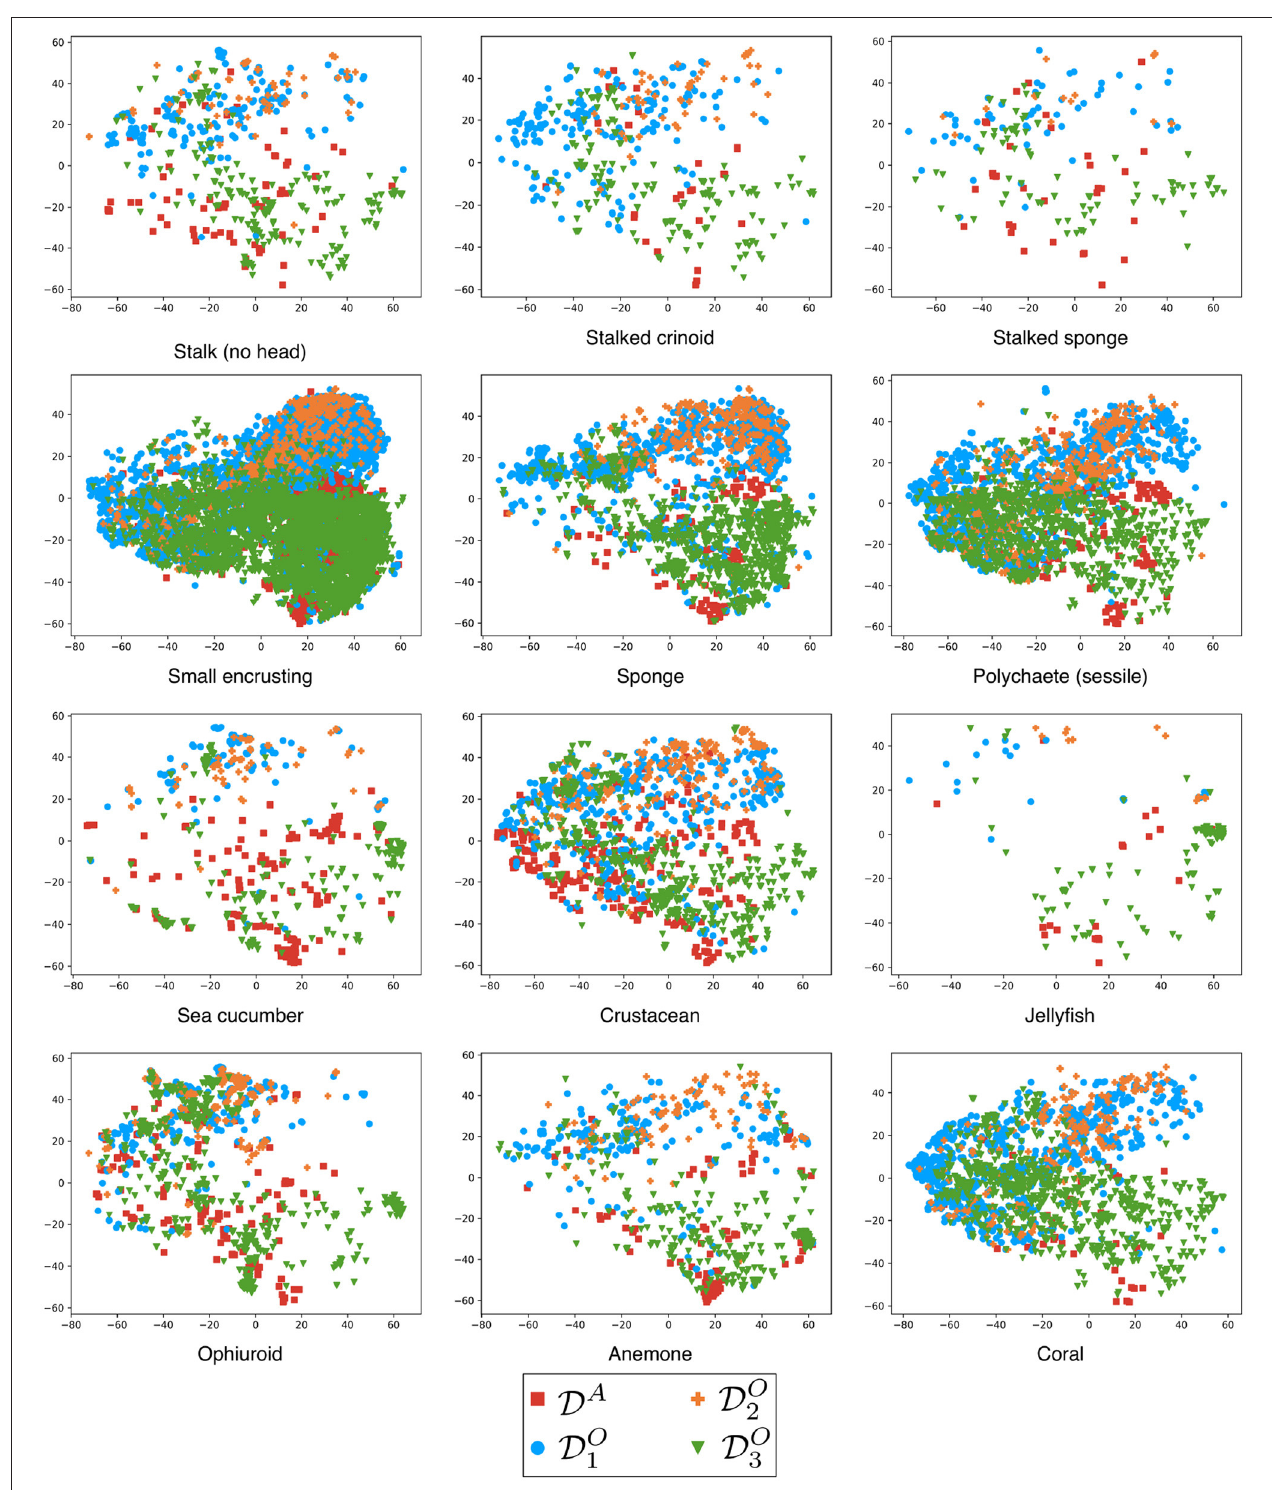
FIGURE 3 | Each scatter plot shows the result of a projection of the image patches of one class for all data sets. The icon color encodes the data set following the same scheme as in Table 1 .